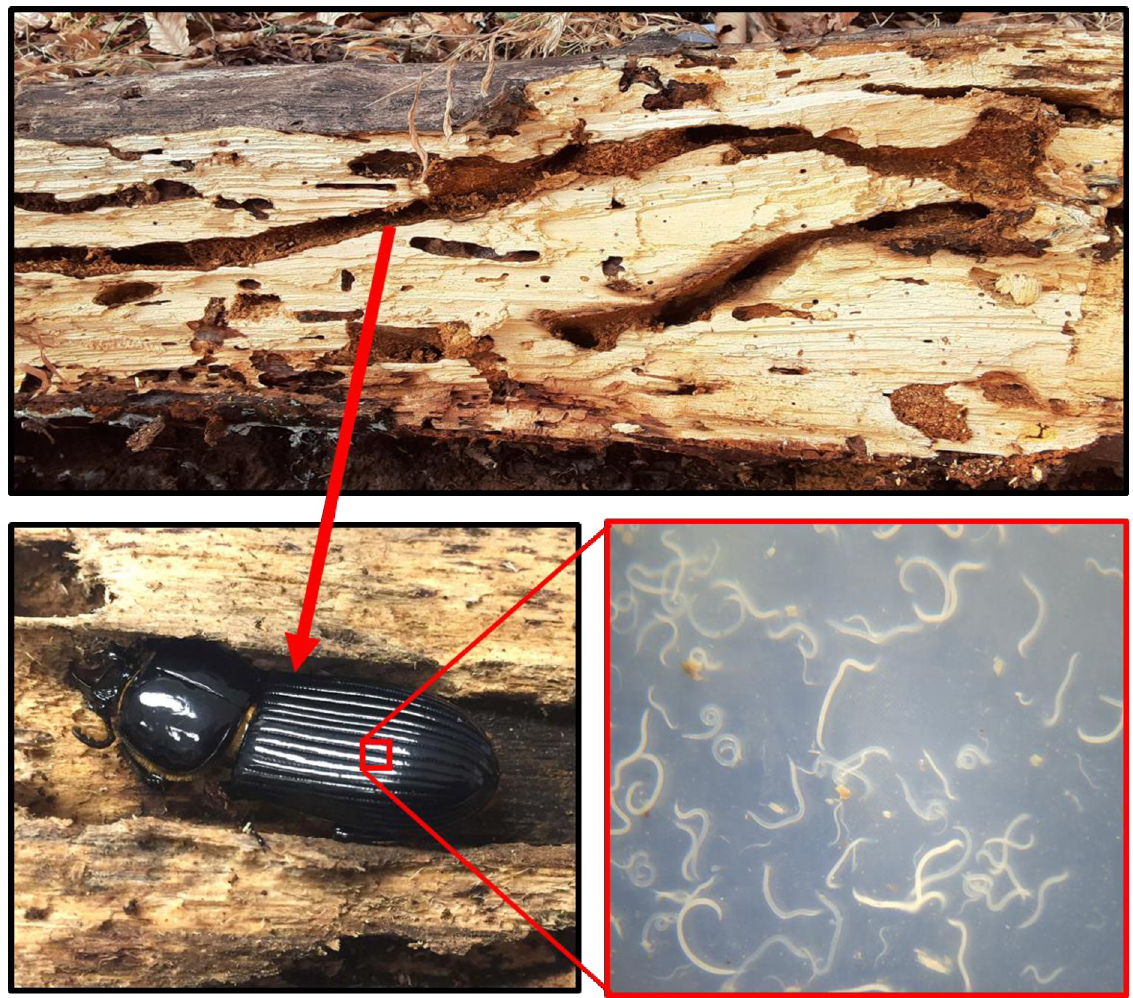
Fig 1. Horned passalus beetle, Odontotaenius disjunctus , in a burrow of a decaying hardwood log (top). Inset shows a collection of nematodes ( Chondronema passali ) taken from the hemocoel of the beetle and photographed in a petri dish. This parasite is common in all passalus beetle populations in the United States and individuals can have dozens to hundreds of nematodes. The mode of transmission of the nematode is unknown.